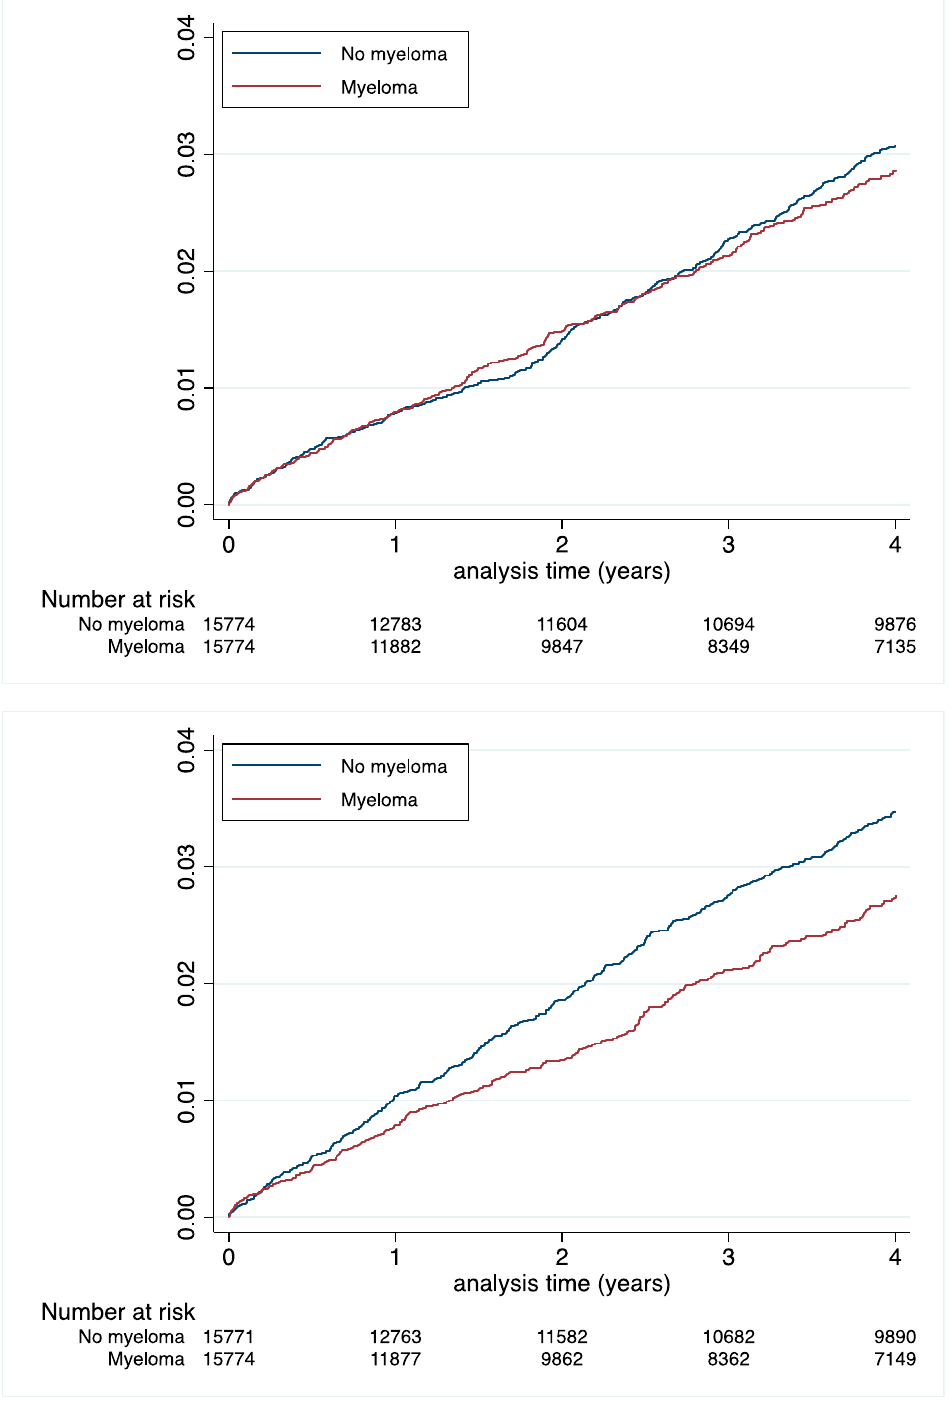
Figure 3. Cumulative incidences of myocardial infarction ( top panel) and ischaemic stroke ( lower panel) in the matched population.